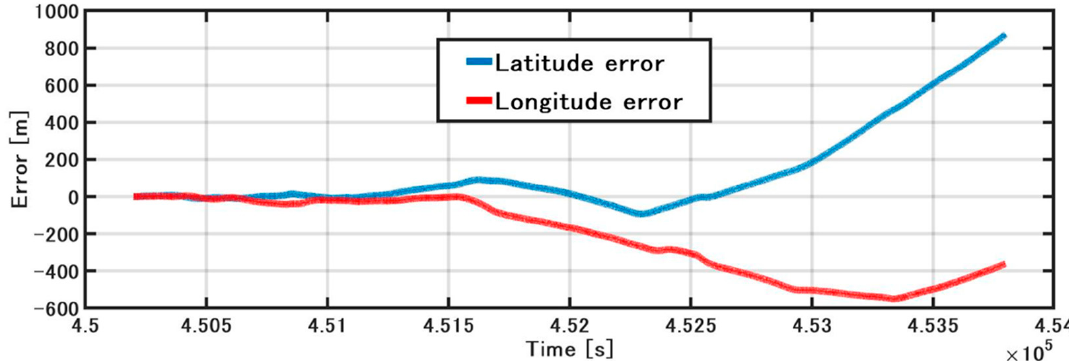
Figure 11. IMU/DVL position error.